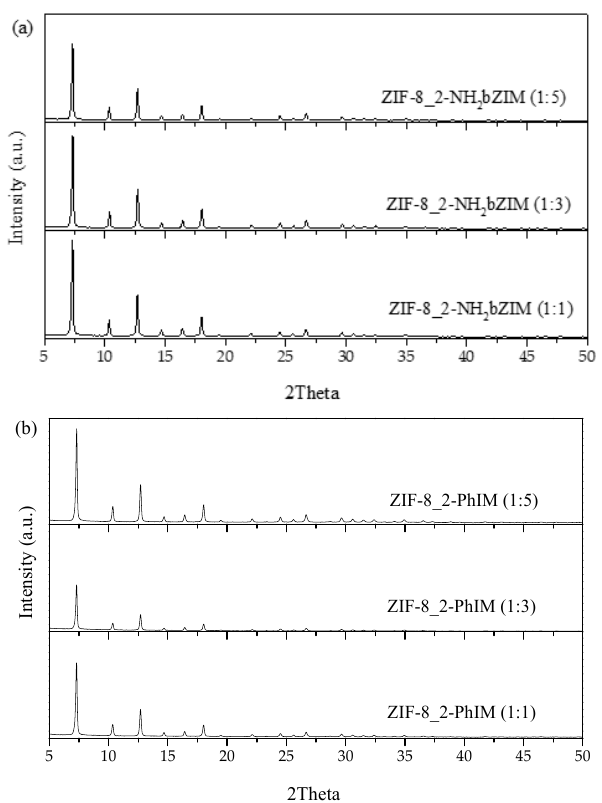
Figure 9. XRD patterns of modified ZIF-8 exchanged by ( a ) 2-aminobenzimidazole (2-NH 2 bZIM) and ( b ) 2-phenylimidazole (2-PhIM) with various ratios between ZIF-8 and exchanged imidazole derivatives.